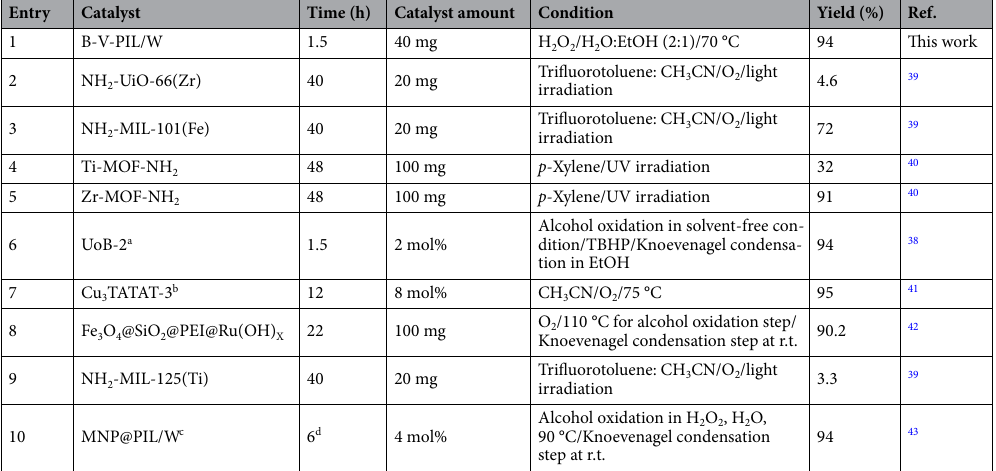
c Tungstate-loaded triazine-based